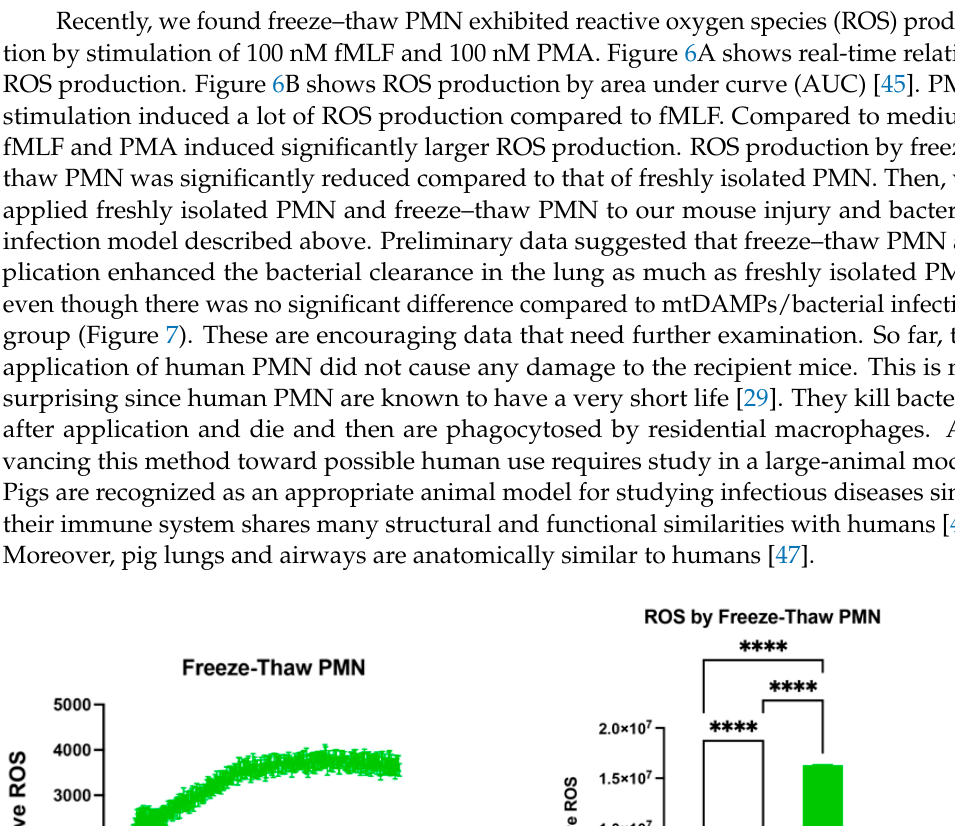
Figure 7. Freeze–thaw PMN induce bacterial killing in vivo. Similar to Figure 5, we applied freshly isolated and freeze–thaw human PMN to our mouse injury/lung bacterial infection model. Alt- hough there was no signi fi cant di ff erence (ns), we could see a tendency that freeze–thaw PMN could be as e ff ective as freshly isolated human PMN. The numbers of animals used for control (CTRL), mtDAMPs, mtDAMPs + fresh PMN (Fresh PMN), and mtDAMPs + freeze–thaw PMN (F-T PMN) were n = 4, n = 7, and n = 8, and n = 8, respectively. Mean and SE values are shown. There was no signi fi cant di ff erence by one-way ANOVA, Tukey. 4. Summary So far, we have shown that the application of mouse PMN of di ff erent strains or even human PMN can help clear lung bacteria after injury using our established mouse models without causing any adverse e ff ects on recipients. Up to 28 days after human PMN appli- cation, we could not detect any lung injury, including fi brosis, mainly due to the short life of PMN. Though the instillation of exogenous PMN into the lung seems contradictory since the patients with pneumonia already have many PMN in the lungs, these instilled PMN will be activated by bacteria and will damage various tissues, including the lungs. This may not be the case. We believe “the timing is everything”. The lungs of established pneumonia patients have many PMN. The important point is when PMN migrated to the CTRL